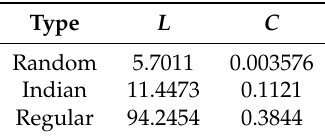
Table 1. Comparison of different